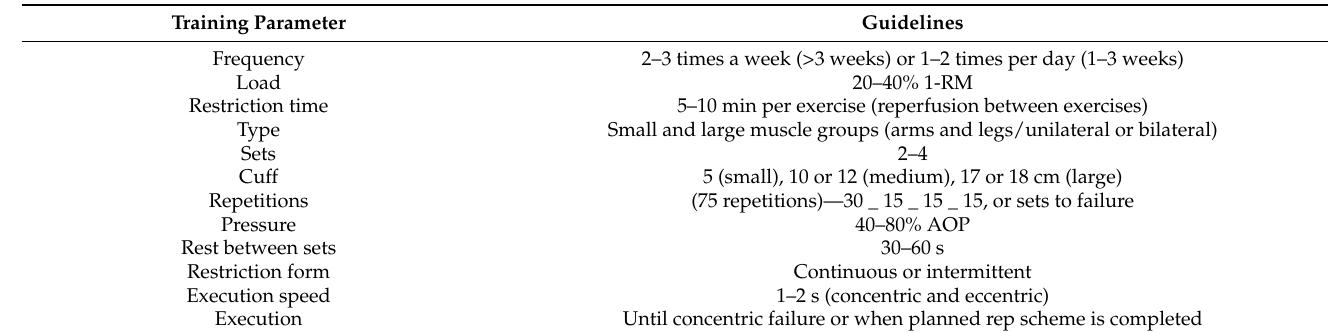
Table 1. Model of exercise prescription with BFRT (Patterson et al., 2019